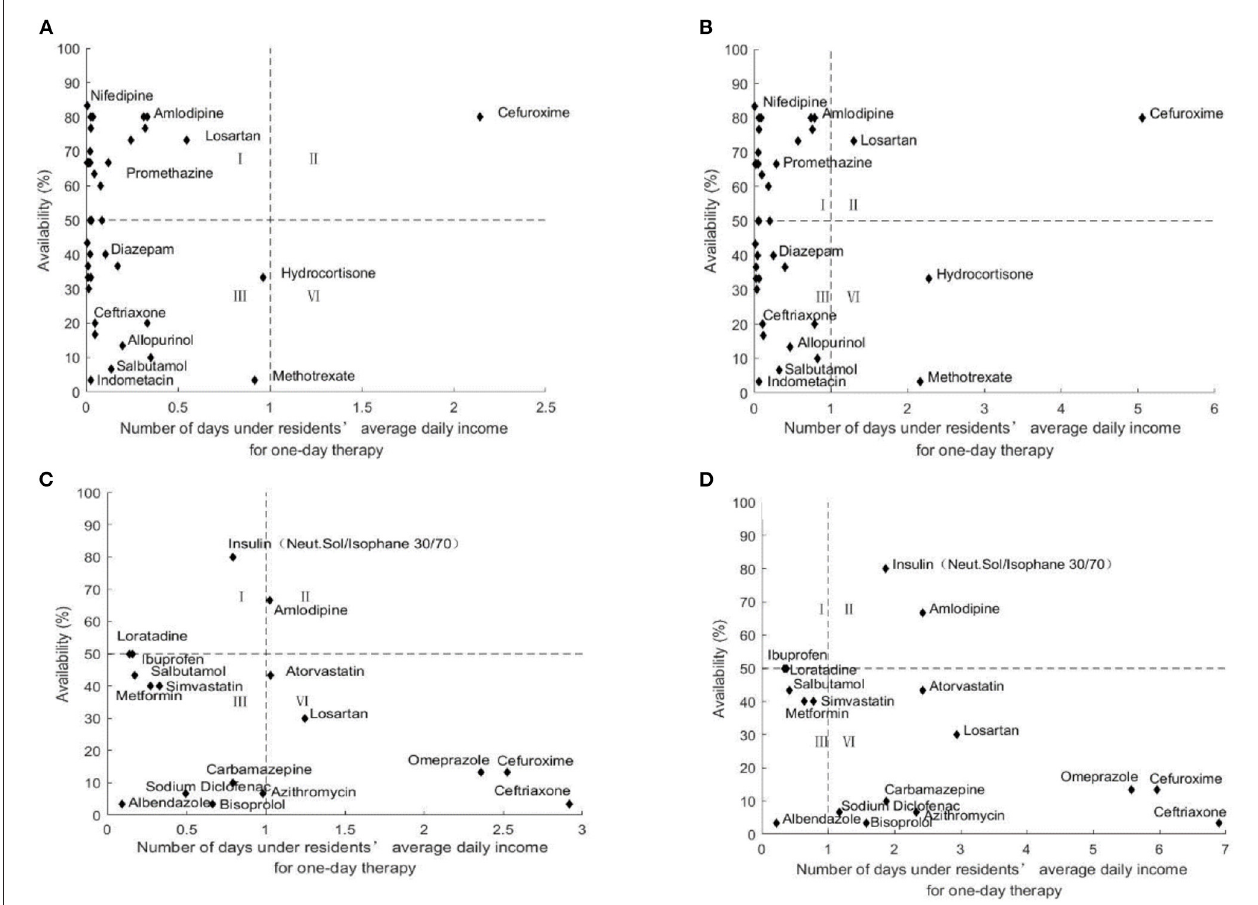
FIGURE 2 | Comprehensive analysis of medicine availability and affordability in Nanjing in 2016. (A) Comprehensive analysis of LPGs availability and affordability for urban residents. (B) Comprehensive analysis of LPGs availability and affordability for rural residents. (C) Comprehensive analysis of OBs availability and affordability for urban residents. (D) Comprehensive analysis of OBs availability and affordability for rural